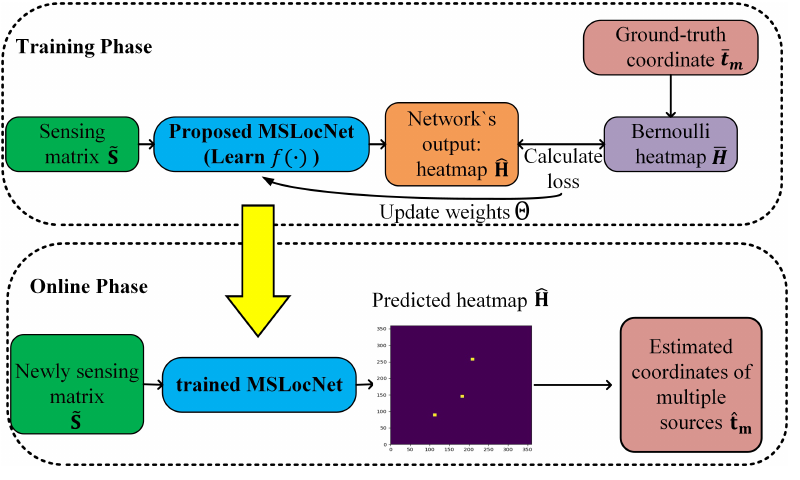
Figure 2. Overview architecture for